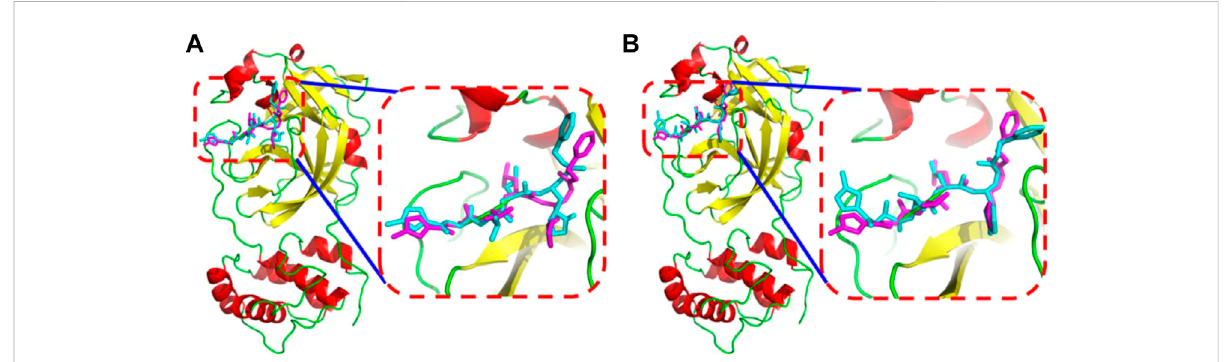
FIGURE 3 The superimposition between the N3 in the crystal structure (magenta) and the N3 from docked conformation (cyan) by AutoDock Vina (A) or by LeDock (B) .